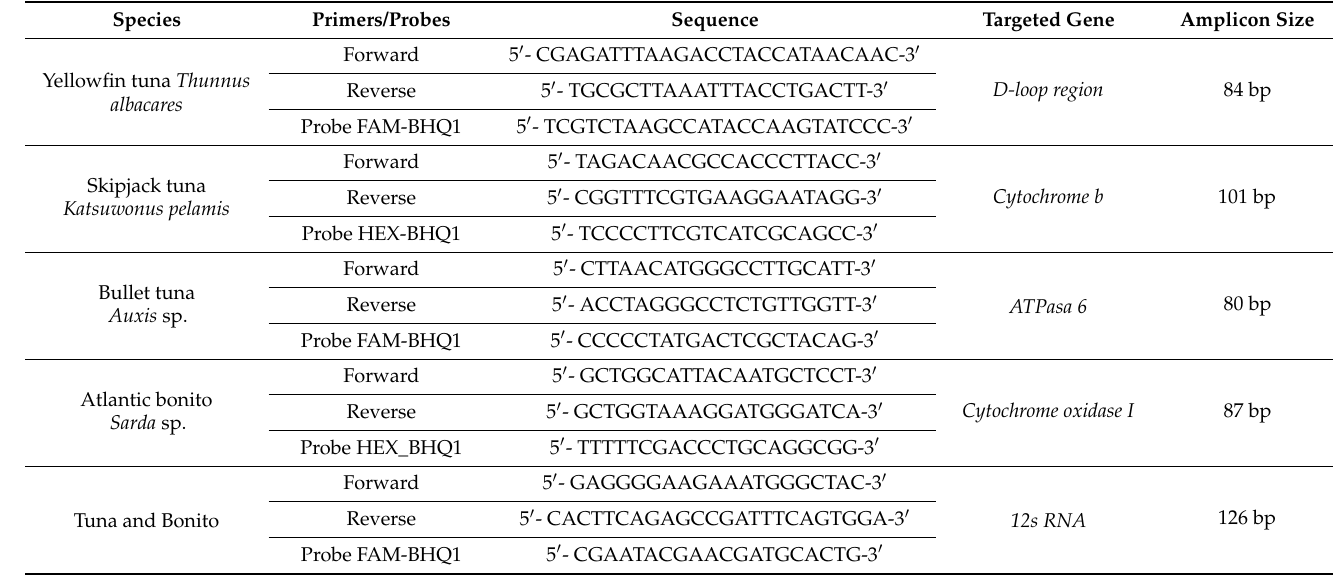
Table 5. Sequences of designed primers and